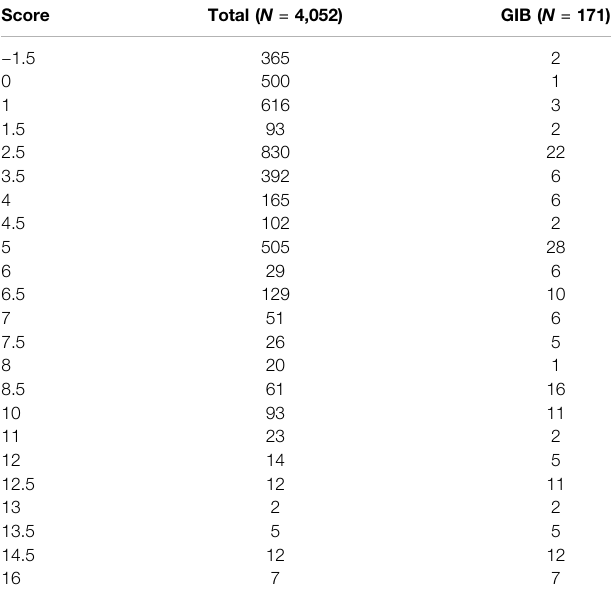
TABLE 4 | Detailed score distribution of (ABC) 2 D score. Score Total ( N = 4,052) GIB ( N =